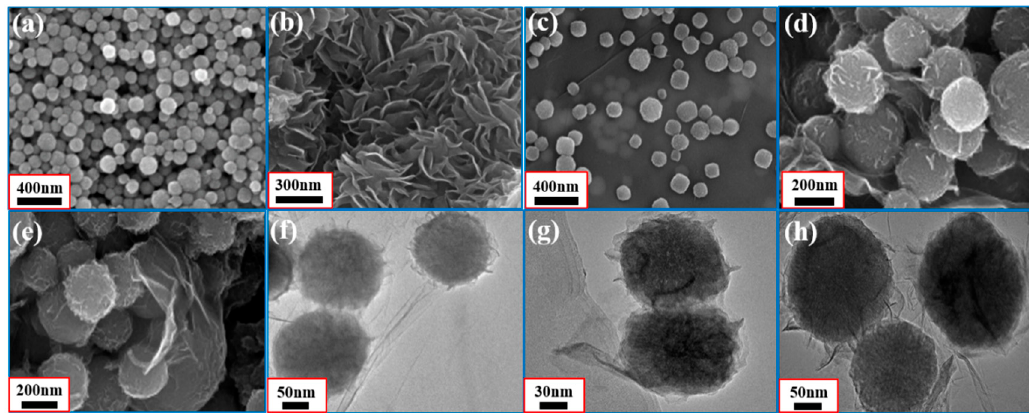
Figure 4. SEM images of ( a ) pure NiS 2 , ( b ) MoS 2 ; SEM images of ( c ) sample A, ( d ) sample B, ( e ) sample C; TEM images of ( f ) sample A, ( g ) sample B, ( h ) sample C. C; TEM images of ( f ) sample A, ( g ) sample B, ( h ) sample